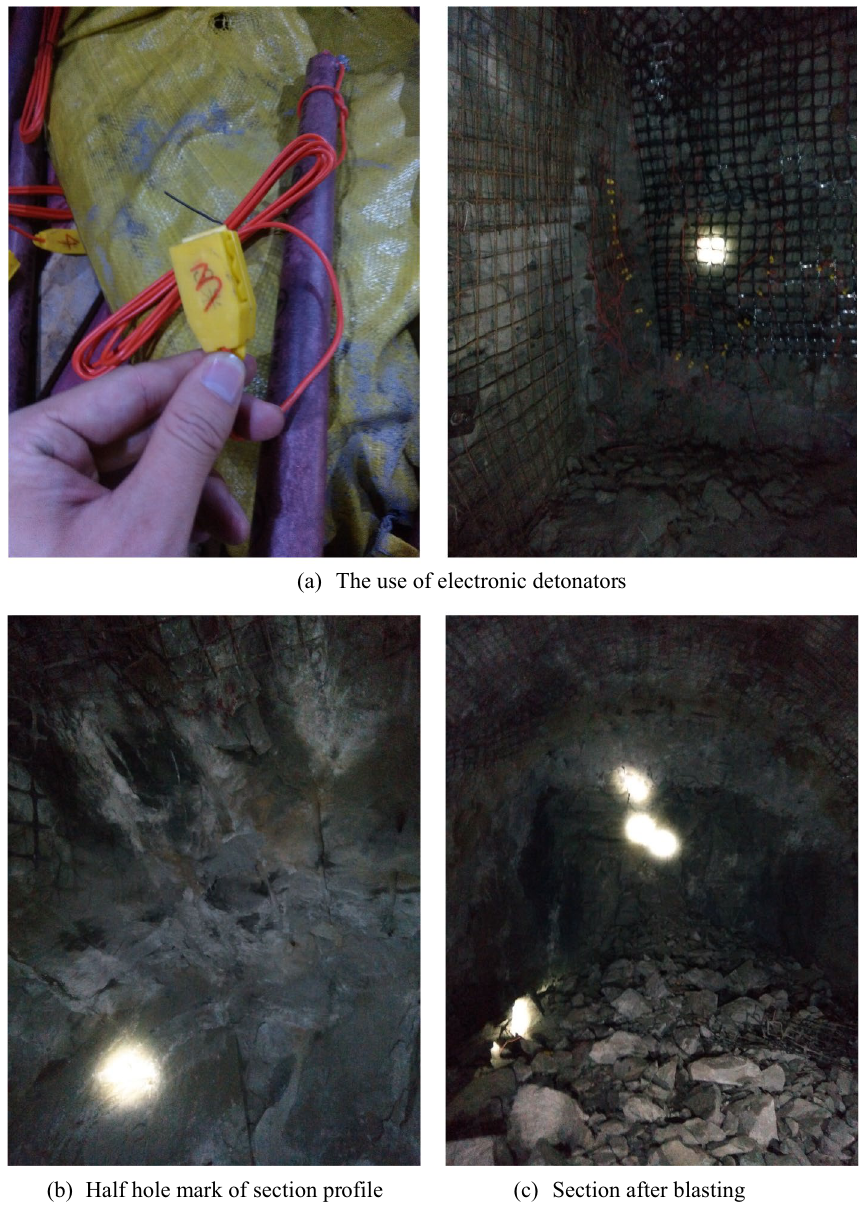
(b) Half hole mark of section profile (c) Section after Fig. 22 Drilling and blasting process of on-site working face. a Setting time of digital electronic detonator; b Half hole mark of section profile; c Section after blasting